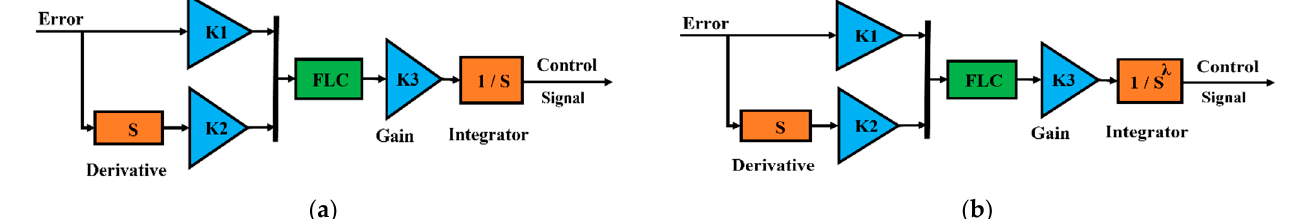
Figure 8. Block diagram of controller ( a ) Fuzzy PI and ( b ) Fuzzy fractional order PI.